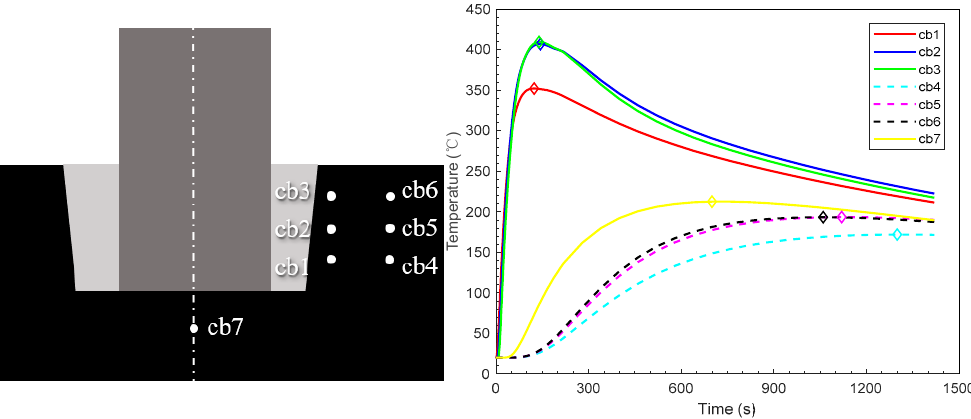
Figure 20. Schematic picture of the points selected in the carbon and the cooling curves.